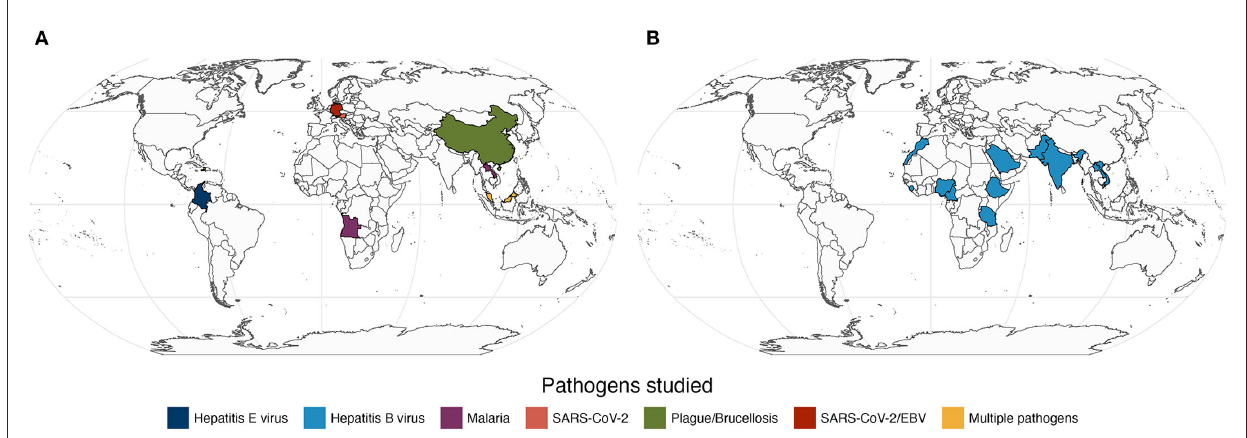
FIGURE1 Map of the study populations and the respective pathogens featured in 9 original research papers (A) and in one systematic review (B) related to seroprevalence of the Hepatitis B virus among health workers (Maamor et al.). Note that Germany contributed with two independent papers (Girl et al. and Sepúlveda et al.) in plot